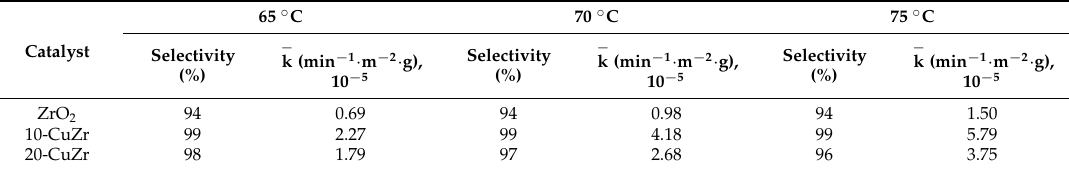
Figure 8. Benzyl chloride conversion levels and diphenylmethane (DPM) selectivities with reaction time over ZrO 2 support, CuZr catalysts at different reaction temperatures (benzne/benzyl chloride stoichiometric ratio = 15 and 0.1 g of catalyst).